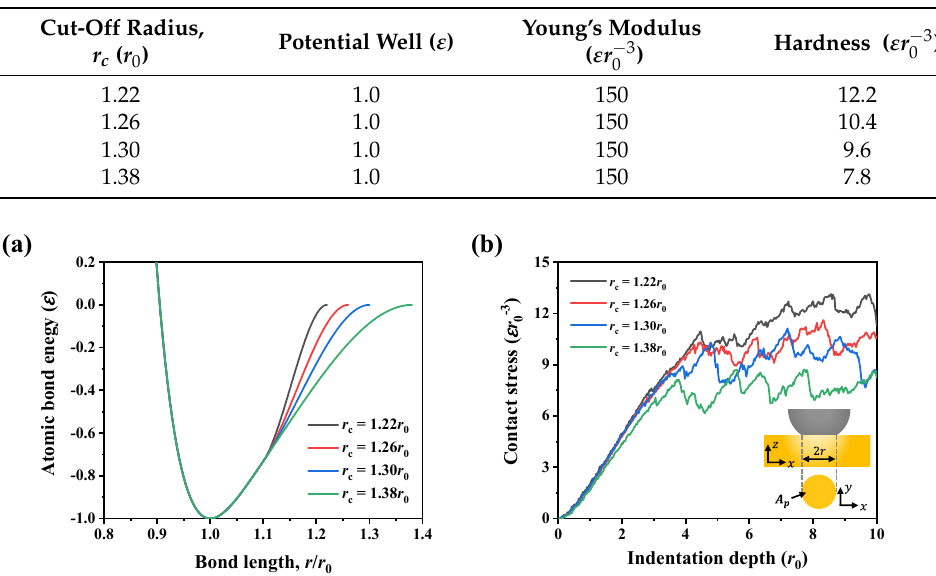
Table A1. Materials with modified Morse potentials and the hardness.